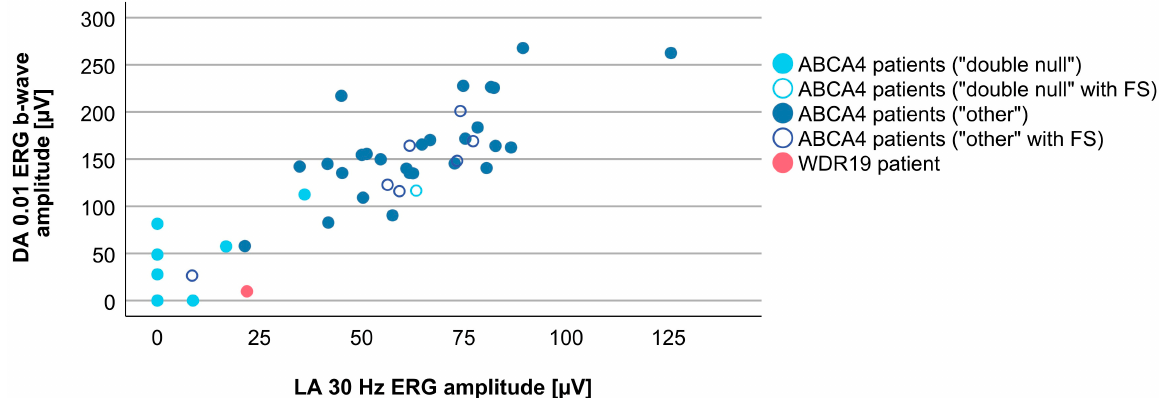
Figure 10. Comparison of PERG P50 amplitudes (representing macular function) between WDR19 patient (red), double null ABCA4 patients (light blue) and ABCA4 patients with other genotypes (dark blue). Foveal sparing patients are marked with empty circles.